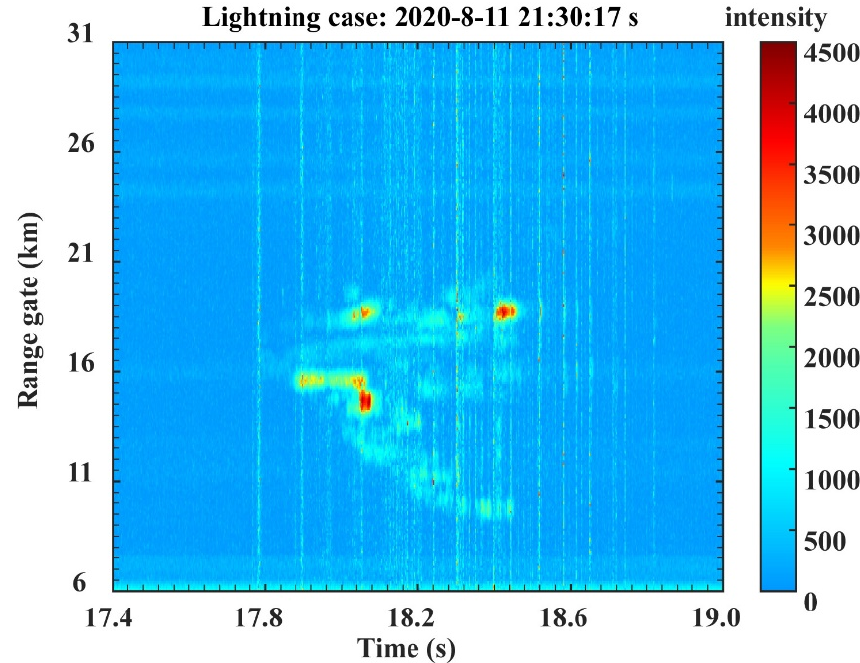
Figure 4. RTI plot of the received lightning echo.